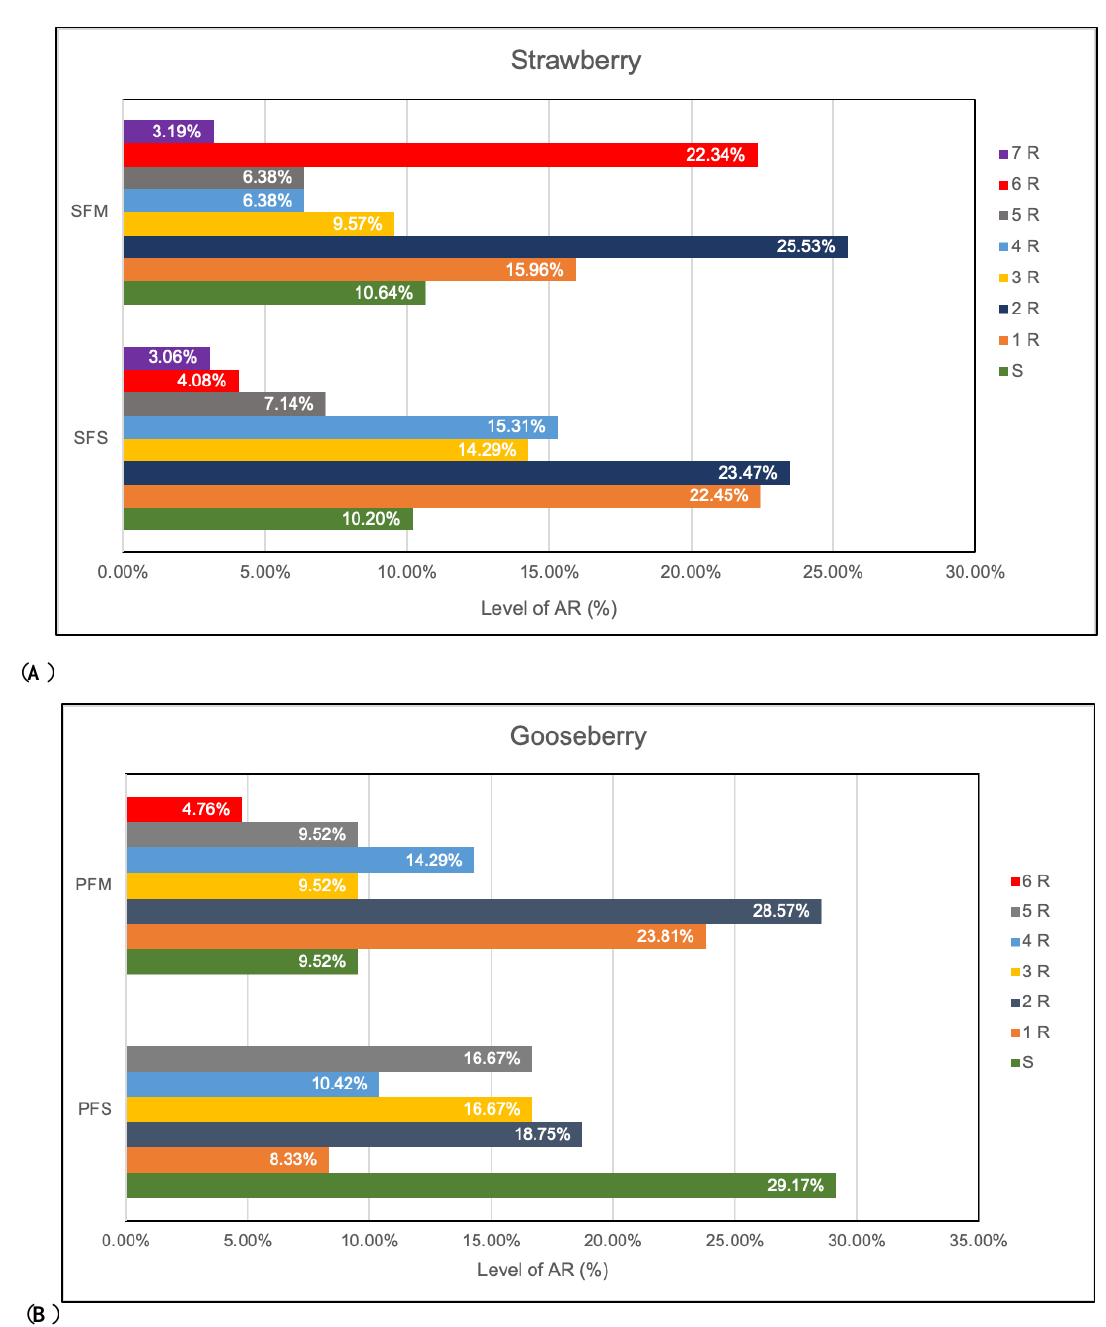
Figure 3. Level of AR (%) in ( A ). strawberry; ( B ). gooseberry. The bars represent the % of bacteria that showed resistance to different number of antibiotics tested. Legend: SFS-strawberries from a local farm grower; SFM: strawberries from low-cost market; PFS: gooseberries from a local farm grower; PFM: gooseberries from low-cost market; S- susceptible; R-resistant.